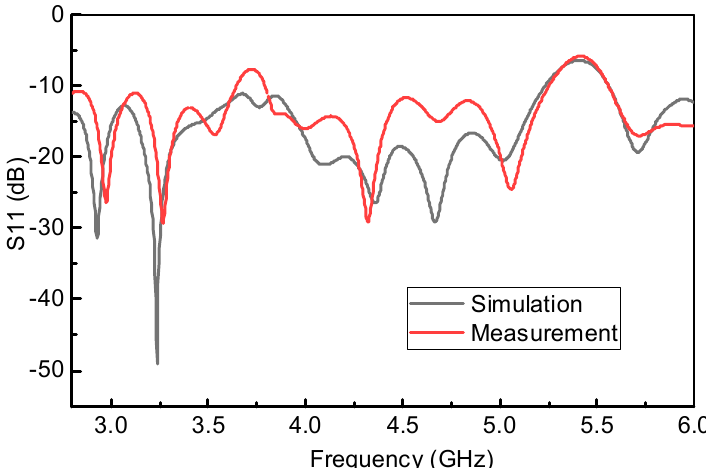
Figure 14. Simulated and Measured response of the Bandwidth-Enhanced Frequency Scanning Fan Beam Array Antenna with an integrated bandpass filter.